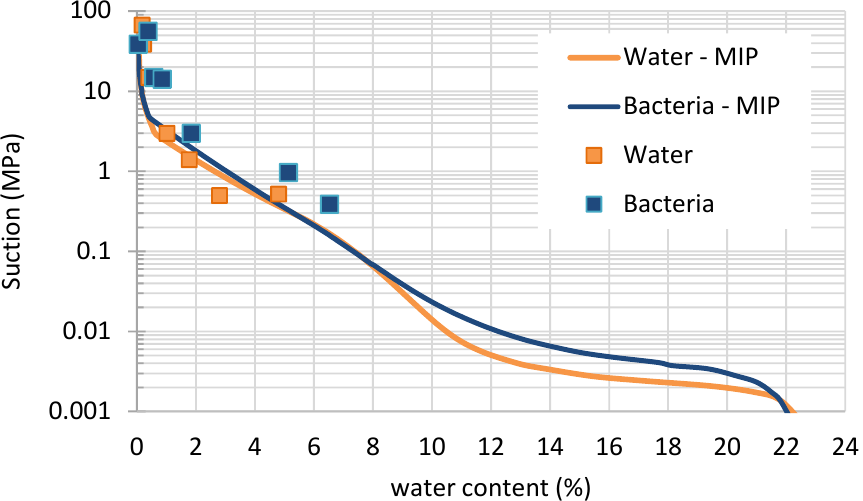
Figure 6. Water retention curve and its adjustment from using the equations proposed in this paper in which the material behaves elastically under isotropic compression. (Bacteria—biocemented soil; water—untreated soil in natural state).